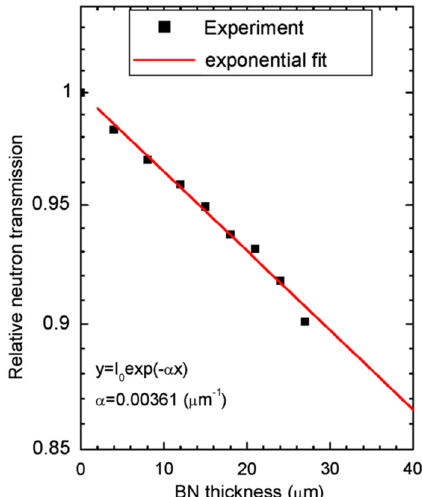
Figure 8. Neutron transmission dependency on h-BN epilayer thickness (the image is reproduced from [31], copyright 2011, with permission from Elsevier).